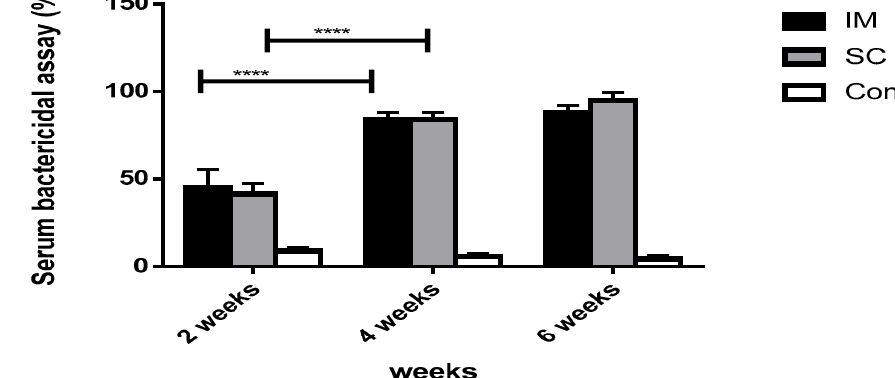
Figure 8. Serum bactericidal activity of rats vaccinated with NmC-BG after 2, 4, and 6 weeks. A bar chart showing the serum bactericidal activity of rats immunized with BG vaccine through intramuscular (IM) and subcutaneous (SC) routes against PBS (control). The bactericidal activity of the serum was determined after incubation with the N. meningitidis strain for 1 h. Error bars represent the standard deviation from the mean. **** indicates significance with p < 0.0001.